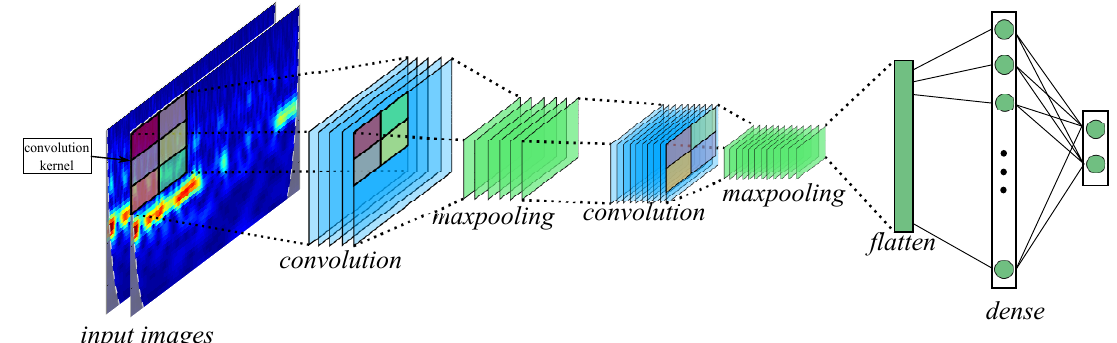
Figure 4. Scheme of CNN architecture used. The CWT input images are pass through two convolutional layers with respective max-pooling. The matrices are flattened and passed by a dense